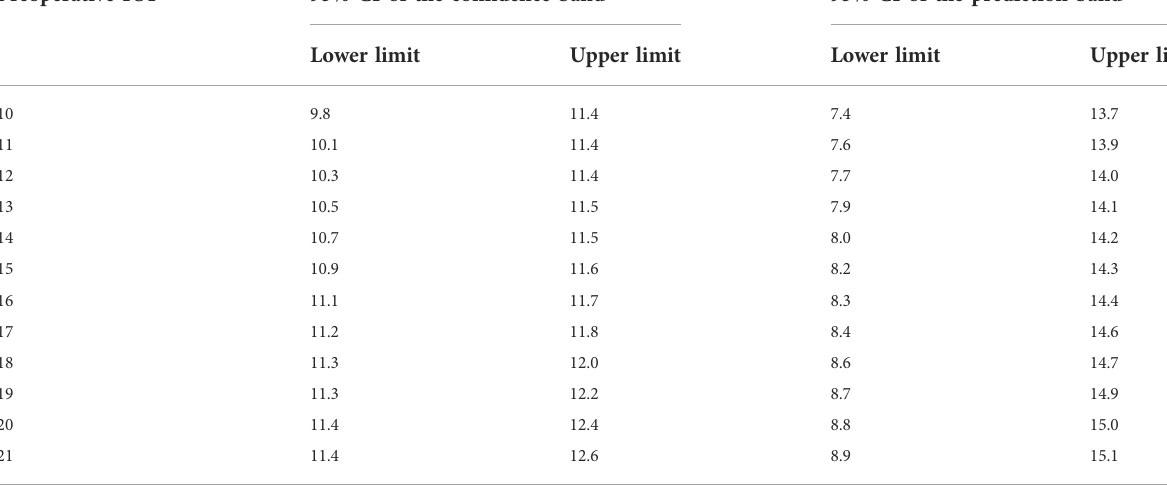
TABLE 4 Estimated con fi dence band and prediction band of postoperative IOP NCT . Preoperative IOP